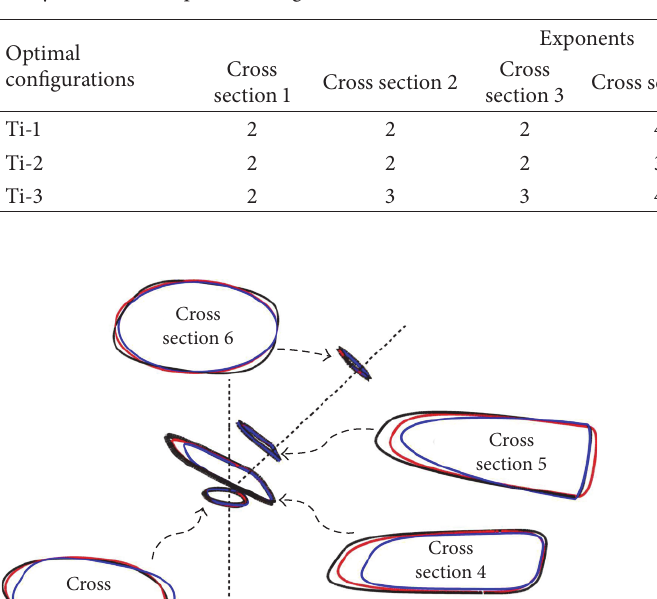
Table 2: Values of the exponents over the cross sections in Figure 2 along with the critical cement damage accumulation parameter at 2.0 × 10 6 cycles for three optimal configurations.